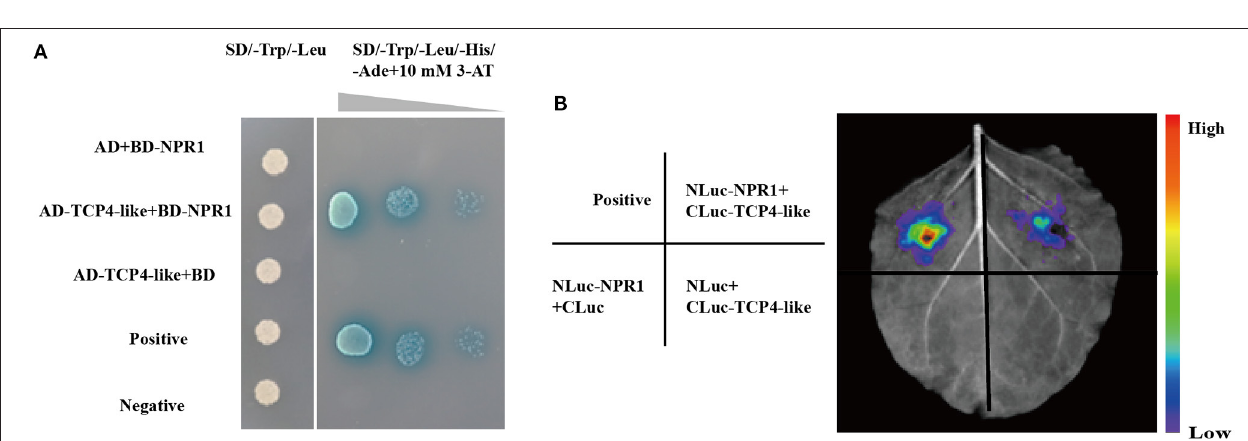
FIGURE 5 | predicted two GhTCP4-like binding sites (GTGGCACC) in the GhICS1 promoter. GhTCP4-like bound to GTGGCACC motif from GhICS1 promoter in the right panel. The lower bands represent unbound probes; lagging bands indicate the complexity of protein and probe. (C) GUS reporter analysis for GhTCP4-like transactivating GhICS1 expression. Schematic diagram of the constructs for GUS reporter assays in tobacco leaf cells in the left panel. (a), (b), (c), (d), (e), and (f) represent p35S:GhTCP4-like, pCAMBIA1300, pGhICS1:GUS, pGhICS1 m1 :GUS, pGhICS1 m2 :GUS and pGhICS1 m1m2 :GUS, respectively. Tobacco leaves were harvested at 48h after agroinfiltration. (D) GUS enzyme activity assayed by 4-MU measurement of treated leaf spots indicated in (C) . “ + ” indicates that the corresponding treatment has been added, “–“ indicates that the corresponding treatment has not been added. Tobacco leaves were harvested at 48h after agroinfiltration. (E) Determination of total SA content. SA of GhTCP4-like -silenced and control plants 1 d after V. dahliae infection was measured by HPLC-MS/MS. Error bar means SD of three independent biological replications. Student’s t -test was performed, * p < 0.05, ** p < 0.01, *** p < 0.001. All experiments were repeated more than three times with similar results.